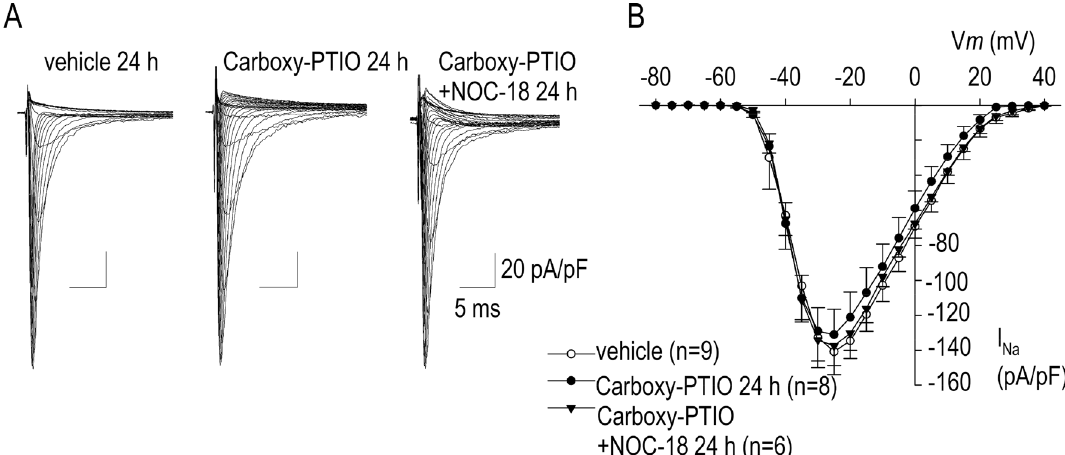
Figure 3. Effects of an NO scavenger carboxy-PTIO (20 μM) on the action of NOC-18 for I Na modulation. ( A ) Representative I Na traces in the control condition (vehicle), 20 μM carboxy-PTIO, and 20 μM carboxy-PTIO plus 1 mM NOC-18 applied for 24 h. ( B ) I–-V relationship of I Na with vehicle, 20 μM carboxy-PTIO, and 20 μM carboxy-PTIO plus 1 mM NOC-18, demonstrating no statistical difference among three groups. Numbers of cell are shown in parentheses. Values represent the mean ± SE.